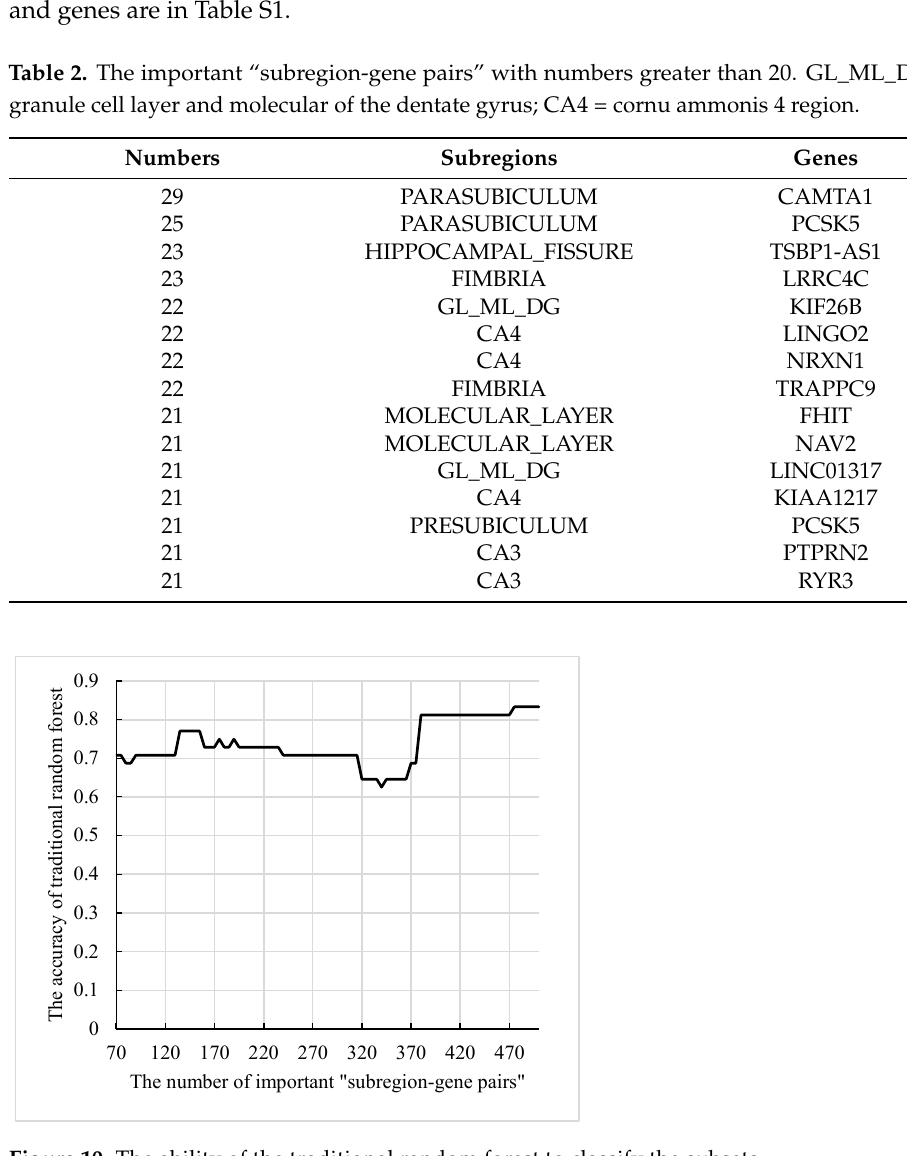
Table 2. The important “subregion-gene pairs” with numbers greater than 20. GL_ML_DG = the granule cell layer and molecular of the dentate gyrus; CA4 = cornu ammonis 4 region. Numbers